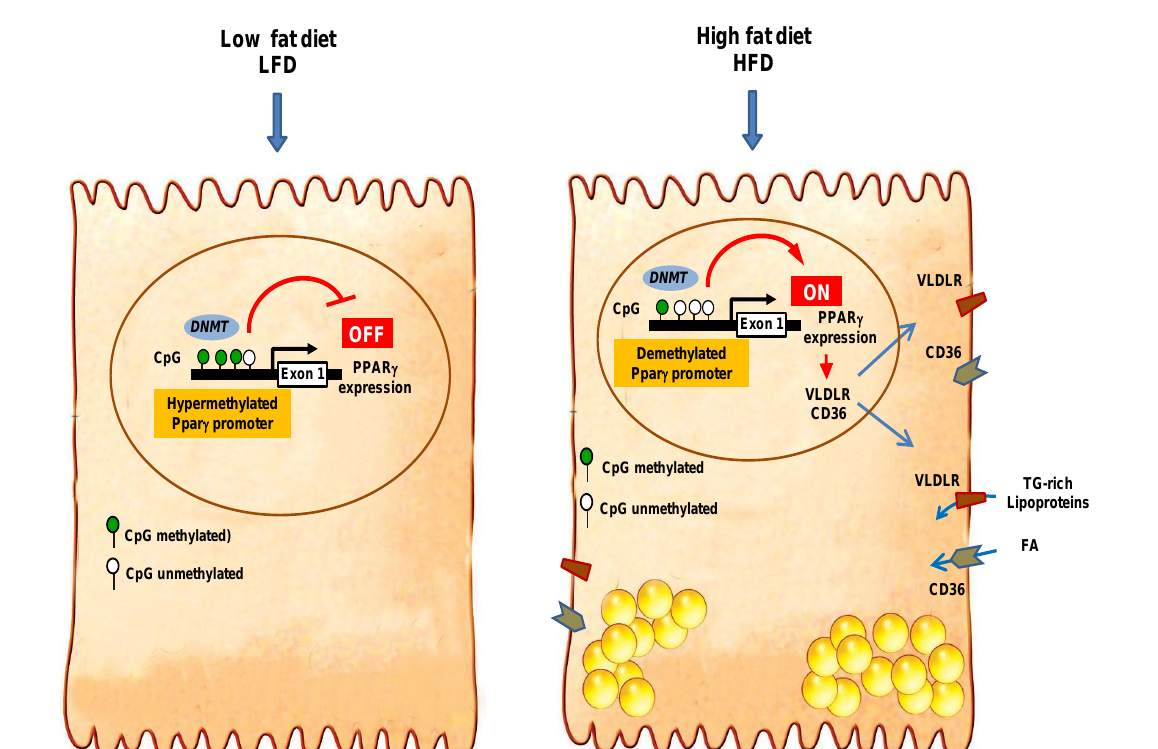
Figure 7. Proposed mechanism of action of high-fat diet and palmitic acid underlying modification of ppar γ promoter DNA methylation and the expression of ppar γ and its target genes in hepatocytes. In low fat diet (LFD), most CpG sites in ppar γ DNA promoter are hypermethylated, and the expression of ppar γ and its target genes vldlr and cd36 is virtually absent. High-fat diet and palmitic acid overload reduces DNMT activity, leading to the demethylayion of most CpG sites of the ppar γ DNA promoter and upregulation of ppar γ expression, which in turn induces the expression of vldlr and cd36 , increasing the uptake of fatty acids and triglycerides in hepatocytes.